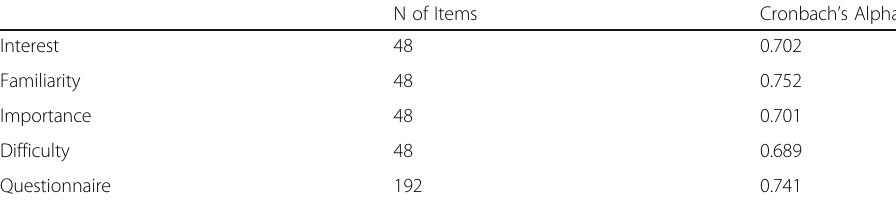
Table 3 Cronbach ’ s Alpha Test for the Self-Selected Topics Questionnaire